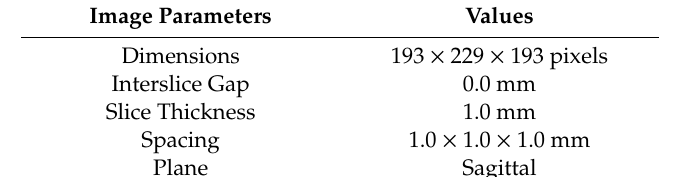
Table 4. Specification of the acquired scans from MNIPD25-T1MPRAGE-1 mm atlas.